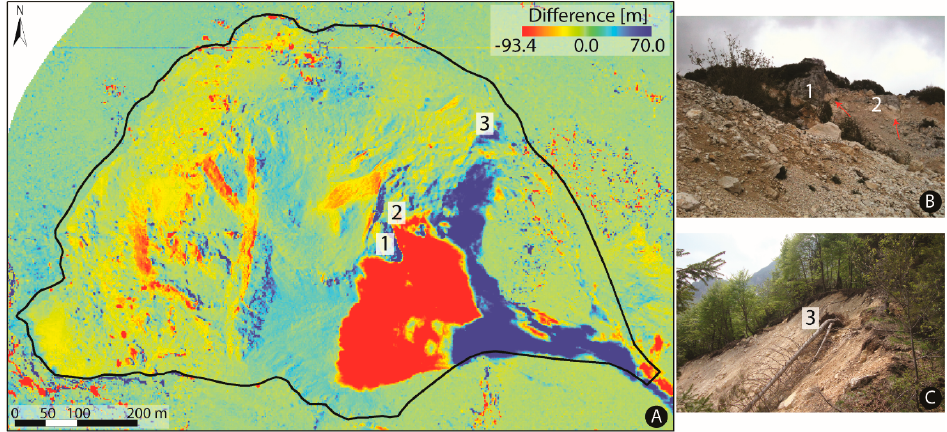
Figure 4. ( A ) DoD map; ( B ) photo of the eastern portion of the 2010 debris flow source area, which clearly shows the surficial movements (red arrows) that occurred at the toe of the megablocks (1 and 2), and ( C ) photo of upper portion of the positive anomalies (3).